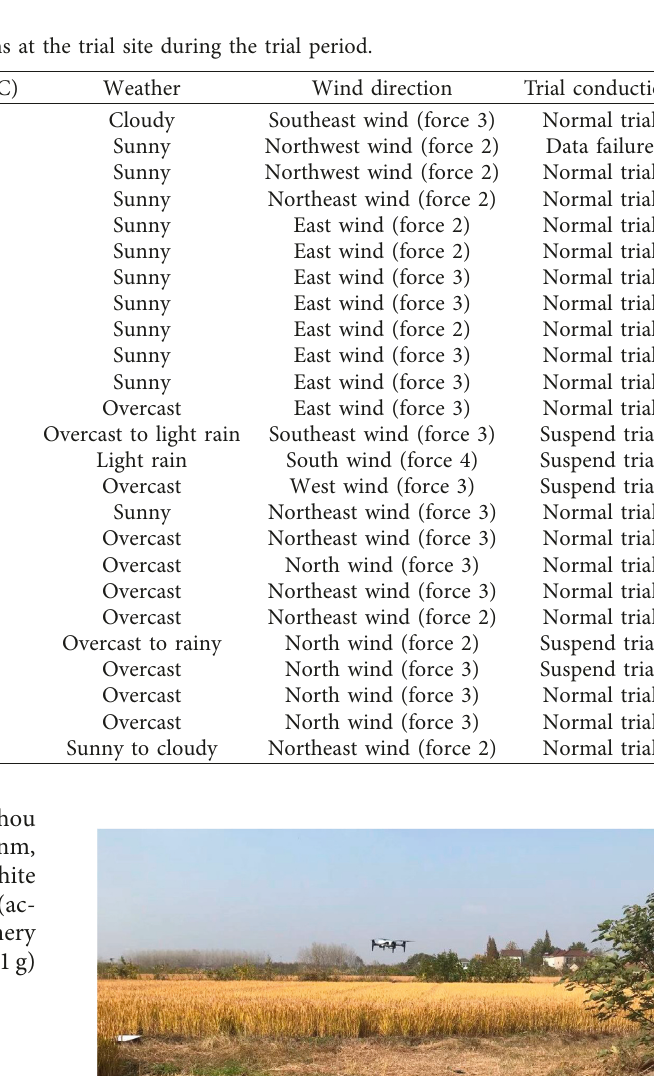
Figure 1: View of remote sensing